Question: Reading the figure, is the described quantity rising or falling?
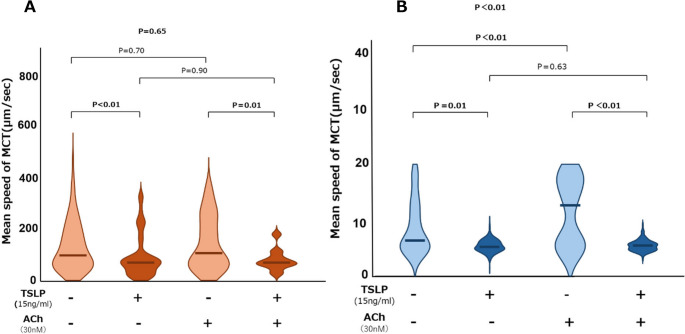
Answer: decreasing